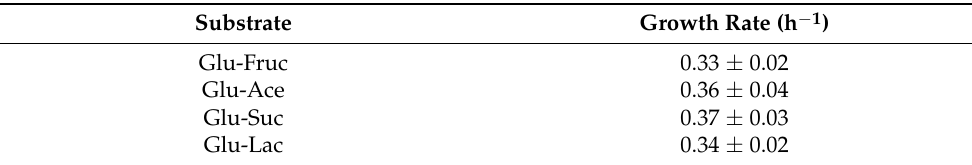
Table 2. Maximum growth rates recorded in the diauxic growth experiment, using optical density as a proxy for cell number. N =